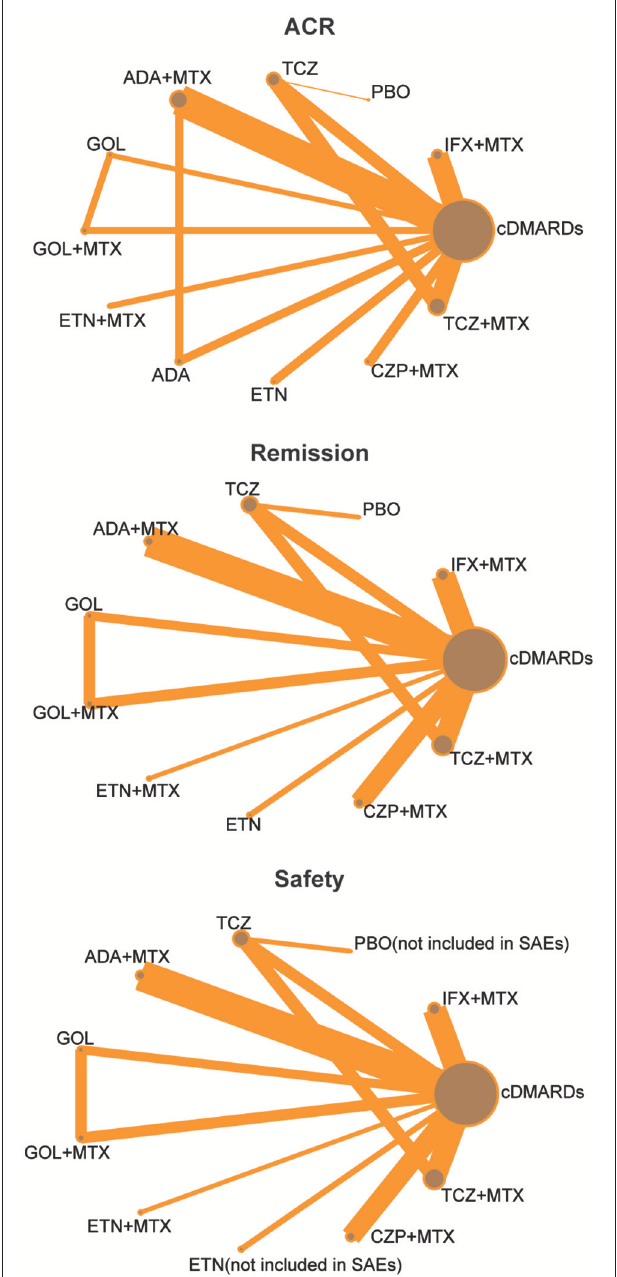
FIGURE 1 | Full network of comparisons of efficacy and safety outcomes (The width of the lines is proportional to the number of trials comparing each pair of treatments; the area of circles represents the cumulative number of patients for each